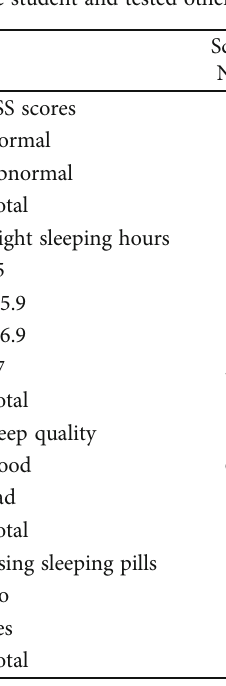
Table 3: Association between fi eld of study and sleep-related variables. Table 3 chi-square results of the association between the specialty of the student and tested other categorial. Bolded numbers represent the highest